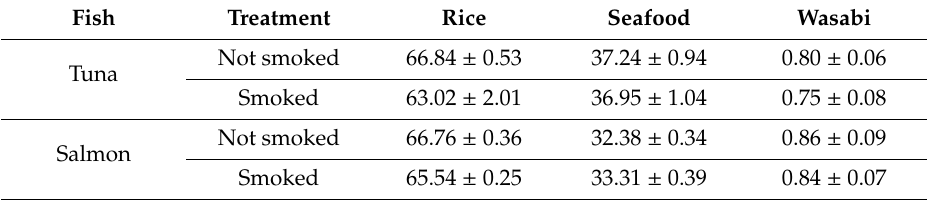
Table 1. Ingredients’ portions (%) of nigiri sushi prepared with salmon and tuna.